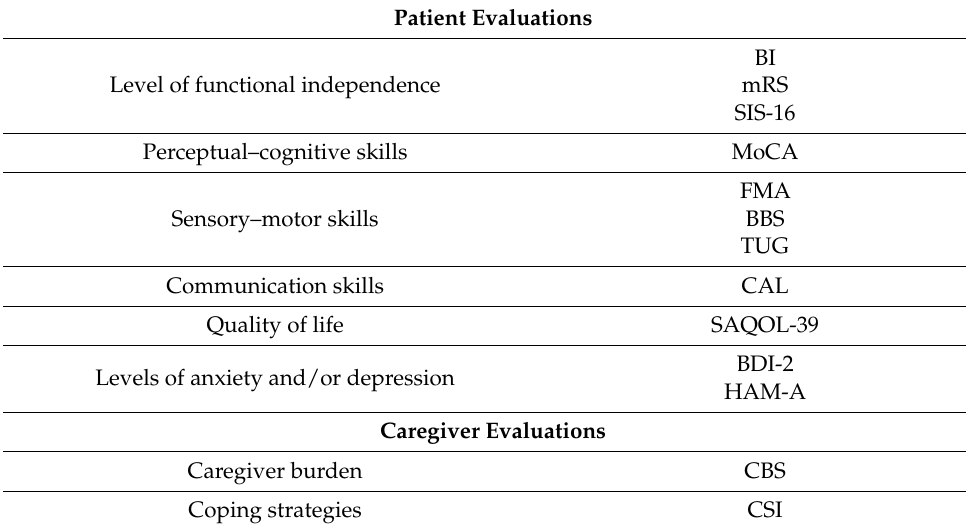
Table 1. List of objectives and